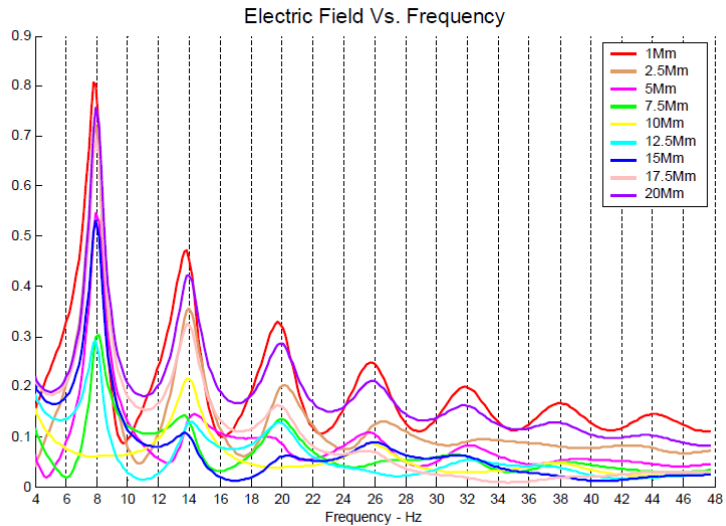
Figure 2. Electric field spectra as a function of SOD [40].